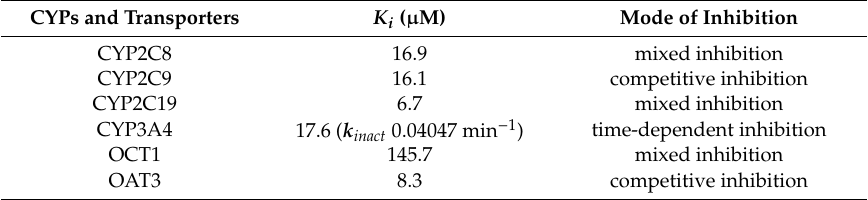
Table 2. Summary of mode of inhibition and inhibition constant ( K i ) of AB-PINACA on CYPs and